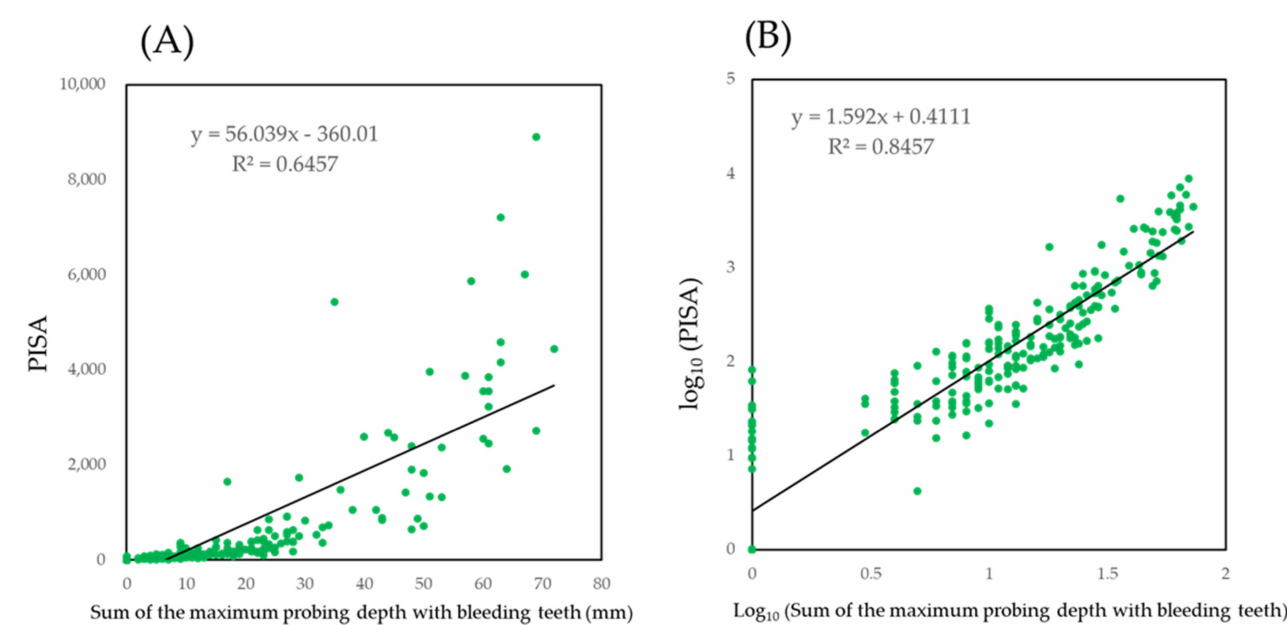
Figure 4. Scatter plot of PISA against sum of the maximum values of PD for each of the bleeding teeth. ( A ) shows the scatter plot by net values. ( B ) shows the values were log 10